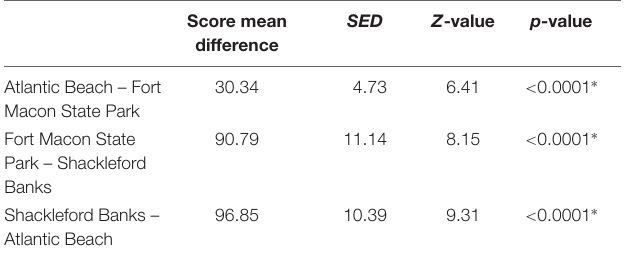
TABLE 2 | Non-parametric multiple comparisons of closest light pollution level (mag/arcsec 2 ) at nests located on each study site using Wilcoxon test on each